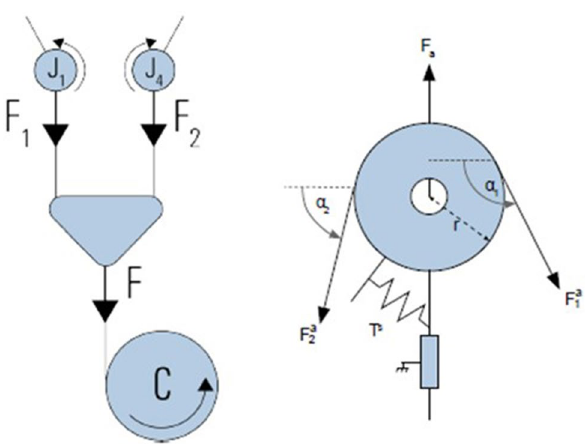
Fig. 5 Differential mechanism with pulleys and cables